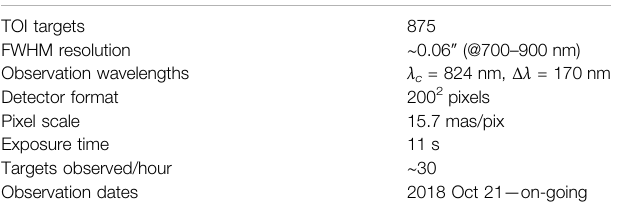
TABLE 2 | The speci fi cations of the SOAR speckle TESS